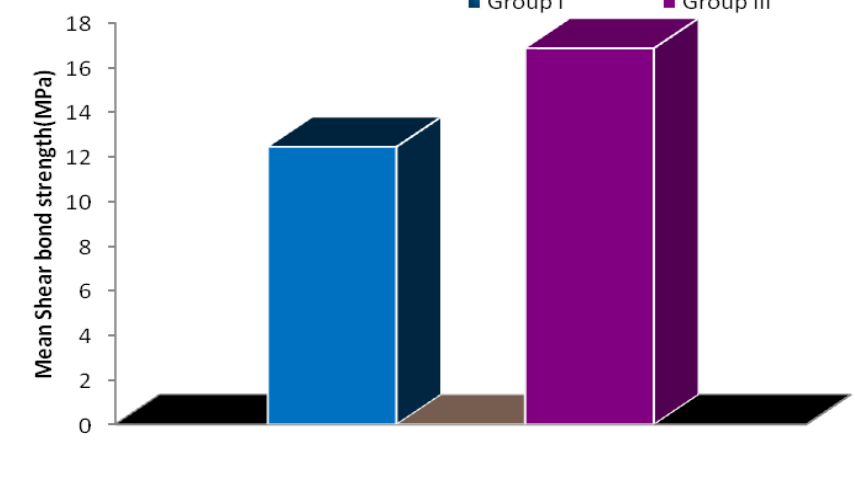
Similar findings were reported by Shwetha M3, Li Y et al., [9] who showed higher value in the indirect bonding group compared to the direct bonding group on the labial surface. Shwetha et al. compared the shear bond strength of the brackets bonded by the conventional direct technique (Group I) and the Indirect Thomas technique (Group II). They found that the mean shear bond strength for Group II bonded indirectly (15.65±4.18 Mpa ) was higher than Group I bonded directly (15.11± 3.98 MPa ), and the difference was statistically non-significant. In a study by Öztürk et al., [21] they compared the shear bond strength (SBS) of brackets and microleakage of a tooth-adhesive- bracket complex bonded with a direct and an indirect bonding technique after thermocycling on the labial surface of the teeth. The mean bond strength in the direct bonding group was higher(12.69 ± 3.53 MPa ) compared to the indirect-bonding Group (11.43 ± 3.63 MPa) with no statistical differences.